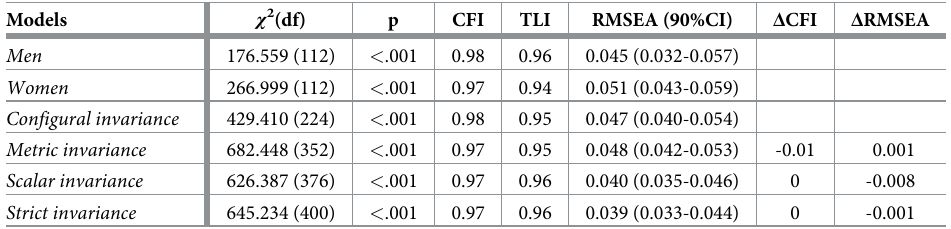
Table 6. Measurement invariance testing between men and women. Models